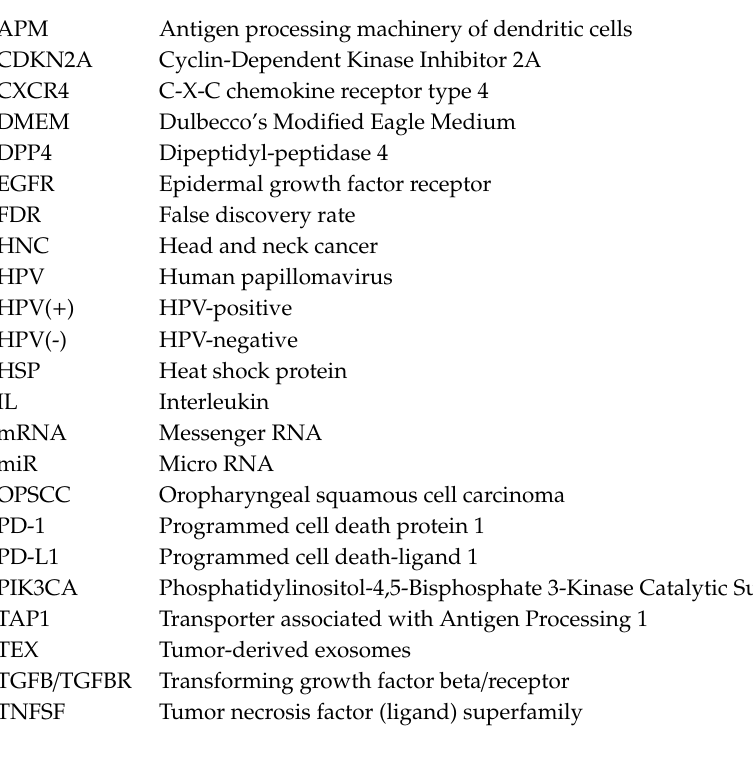
s1. Table S1: Detailed list of miR expression in cell lysates and exosomes, Table S2: Detailed list of IDT primers (A) and Qiagen primers (B) used for mRNA